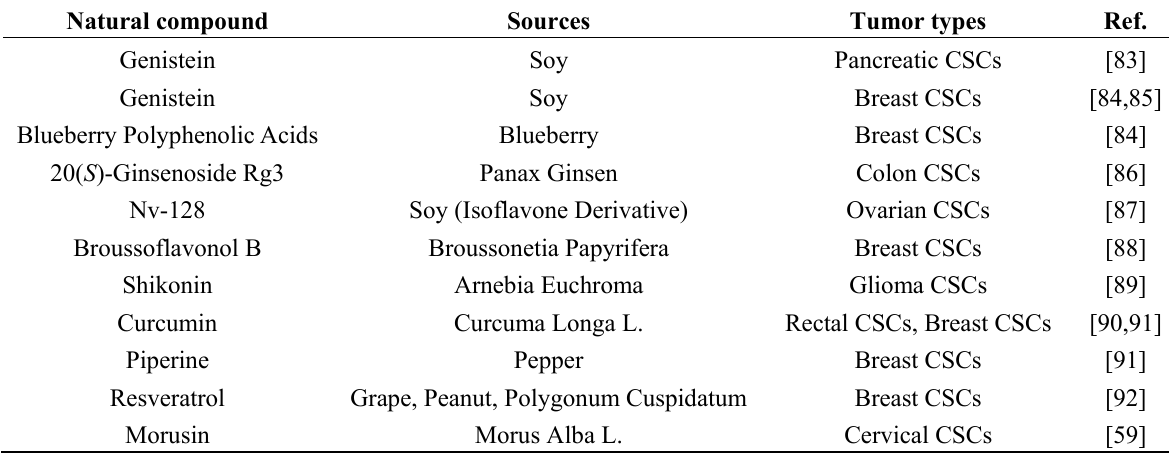
Table 1. Natural inhibitors of cancer stem cells